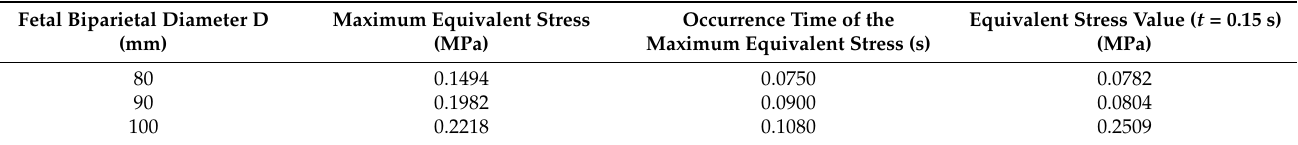
Table 3. Equivalent stress data